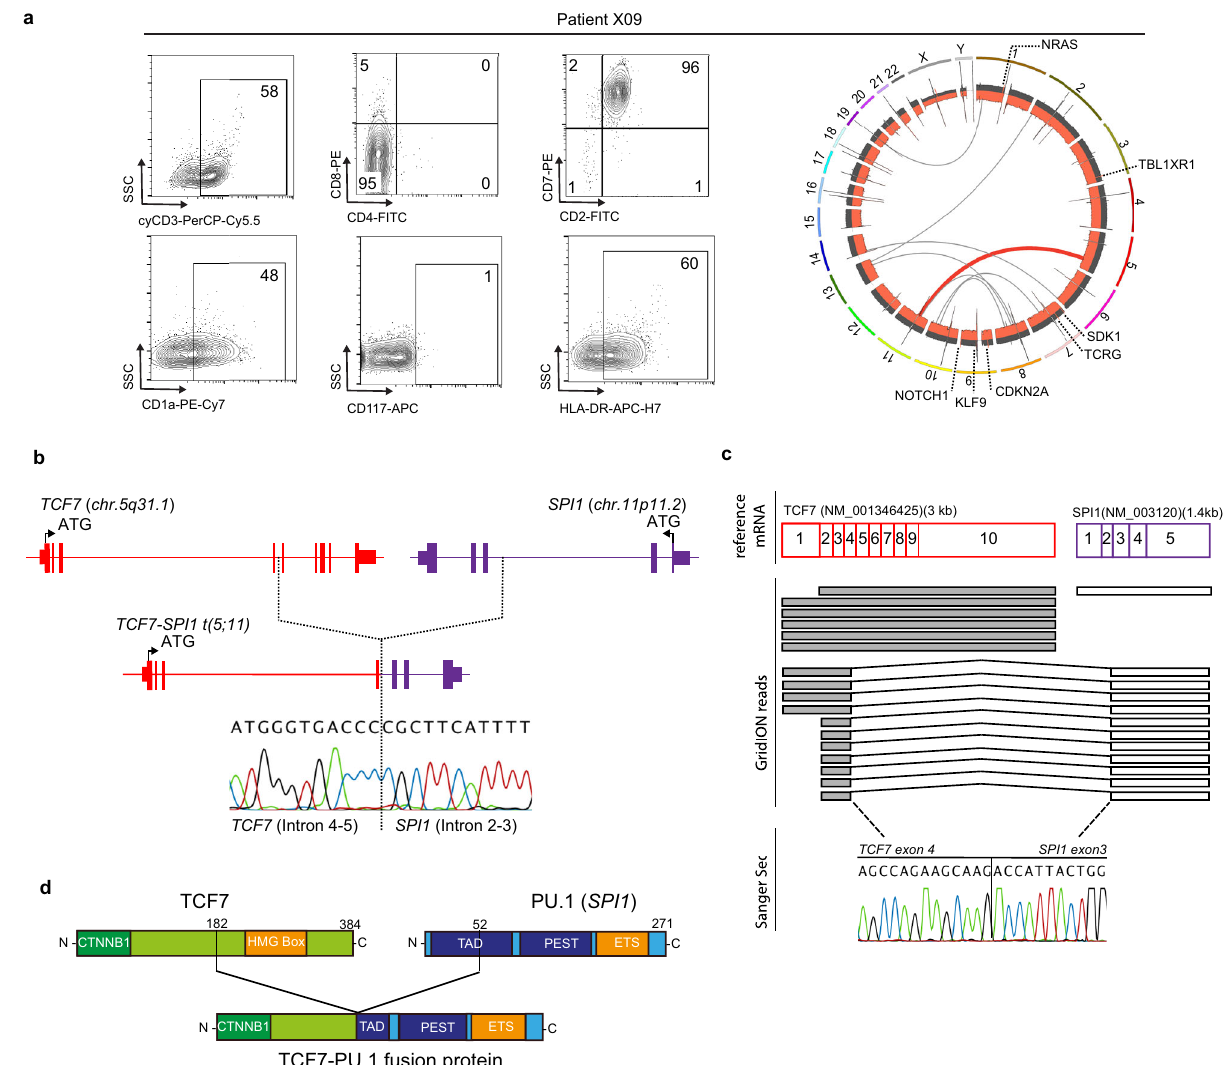
Fig. 1 Identi fi cation and characterization of the TCF7-SPI1 fusion in patient X09 with T-cell acute lymphoblastic leukemia. a Left panel: fl ow cytometry staining of the X09 patient sample for cyCD3, CD1a, CD4, CD8, CD117, CD2, CD7, HLA-DR. Right panel: Circos plot showing the translocation between chromosomes 5 and 11 in the X09 patient. Additional mutations are shown with their respective chromosomal location. b Scheme of the t(5;11) translocation between TCF7 and SPI1 . The breakpoints are located at TCF7 intron 4-5 (Chr. 5) and SPI1 intron 2 – 3 (Chr. 11). c Long read nanopore sequencing con fi rming the translocation with the resulting GridION reads shown schematically alongside Sanger sequencing con fi rmation of the breakpoint region. d Schematic representation of the resulting TCF1-PU.1 ( TCF7-SPI1 ) fusion protein. The different domains are shown. CTNNB1: β -catenin